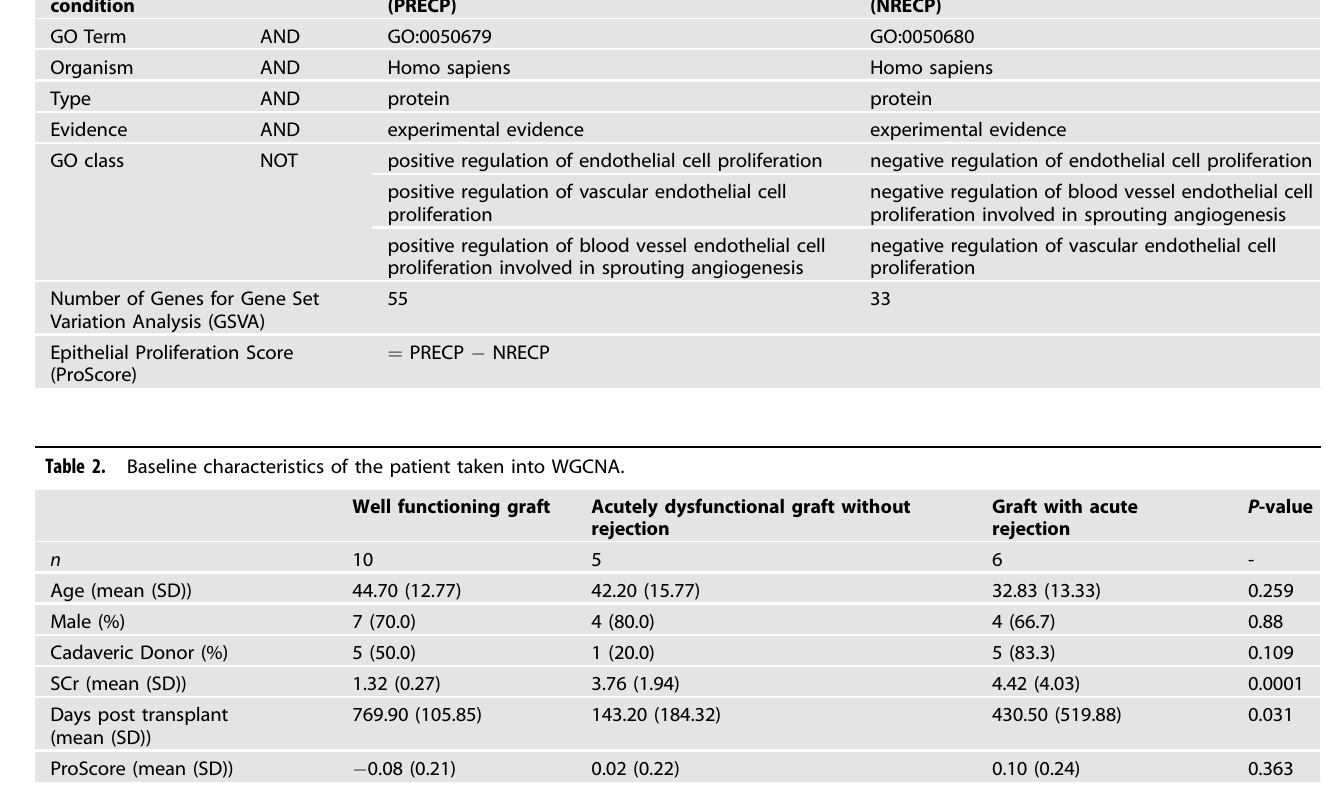
(Fig. 4F Fucci fl uorescence) as the tubule fully repaired (Fig. 4F GFP fl uorescence), which was con fi rmed further by the change of